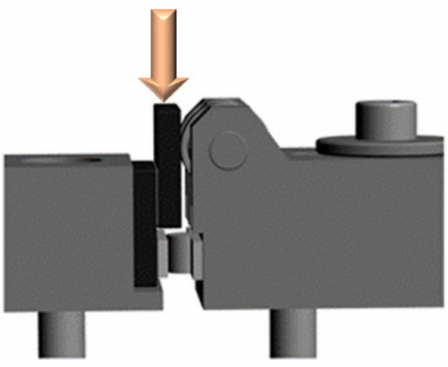
Figure 3. Fixtures to avoid bending and rotation of the adherends in the SLO